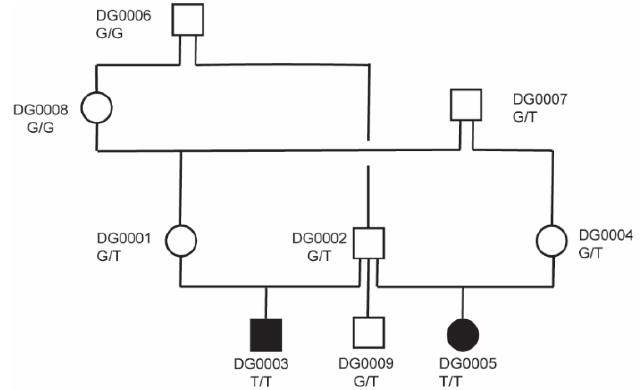
Figure 3. Pedigree of the investigated Dogo Argentino family. Filled and open symbols represent affected and unaffected dogs, respectively. Squares represent males, and circles females. Laboratory identifiers and genotypes at the PRKG2 :c.1634+1G>T variant are indicated for all dogs.